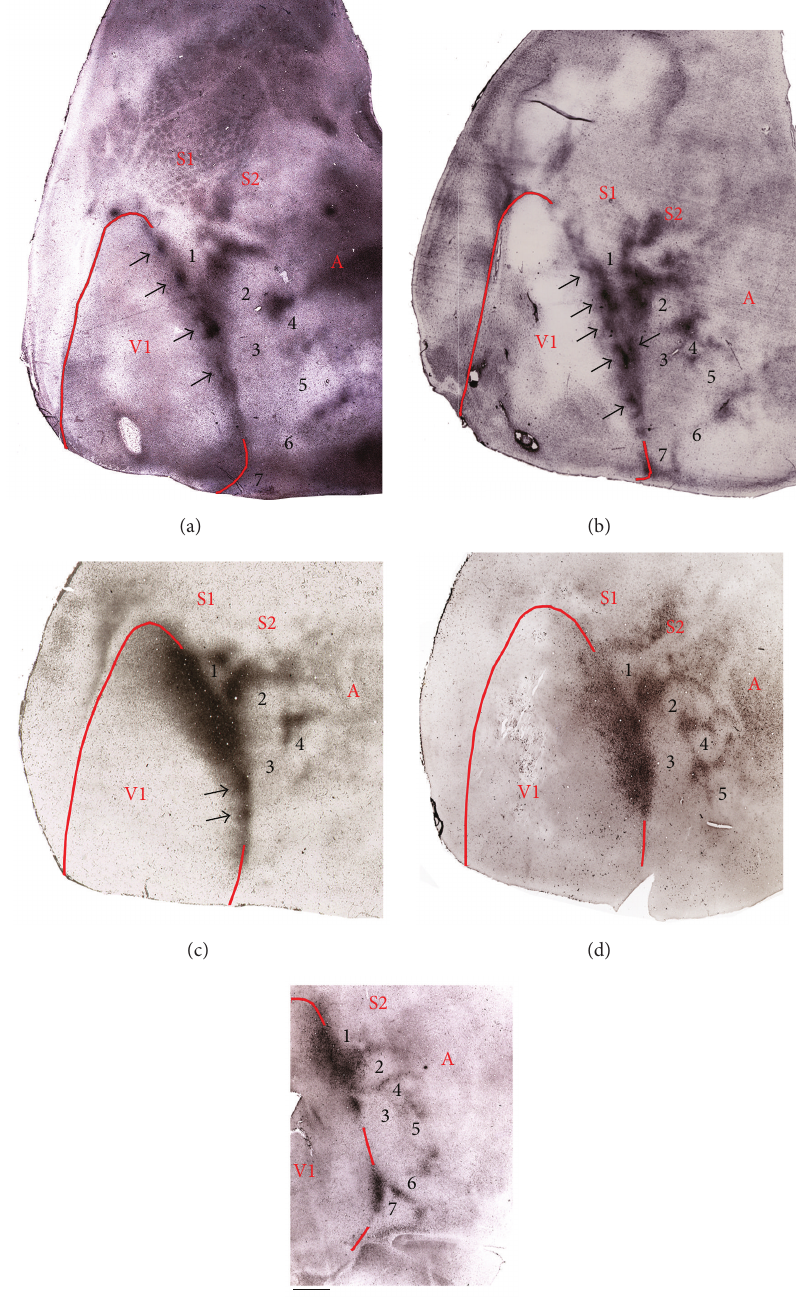
Figure3:PatternsofcallosalconnectionsintherighthemisphererevealedfollowingmultipleinjectionsofHRPintotheoppositehemisphere. ((a) and (b)) Albino rabbits (cases 86-12 and 87-1, resp.). ((c)–(e)) Dutch belted rabbits (cases R53, R5, and R6, resp.). Arrows indicate bead- like patches. Opposing arrows in (b) illustrate a double patch. Numbers indicate corresponding areas in the five cases shown. Medial is to the left and posterior is down. Scale bar = 2